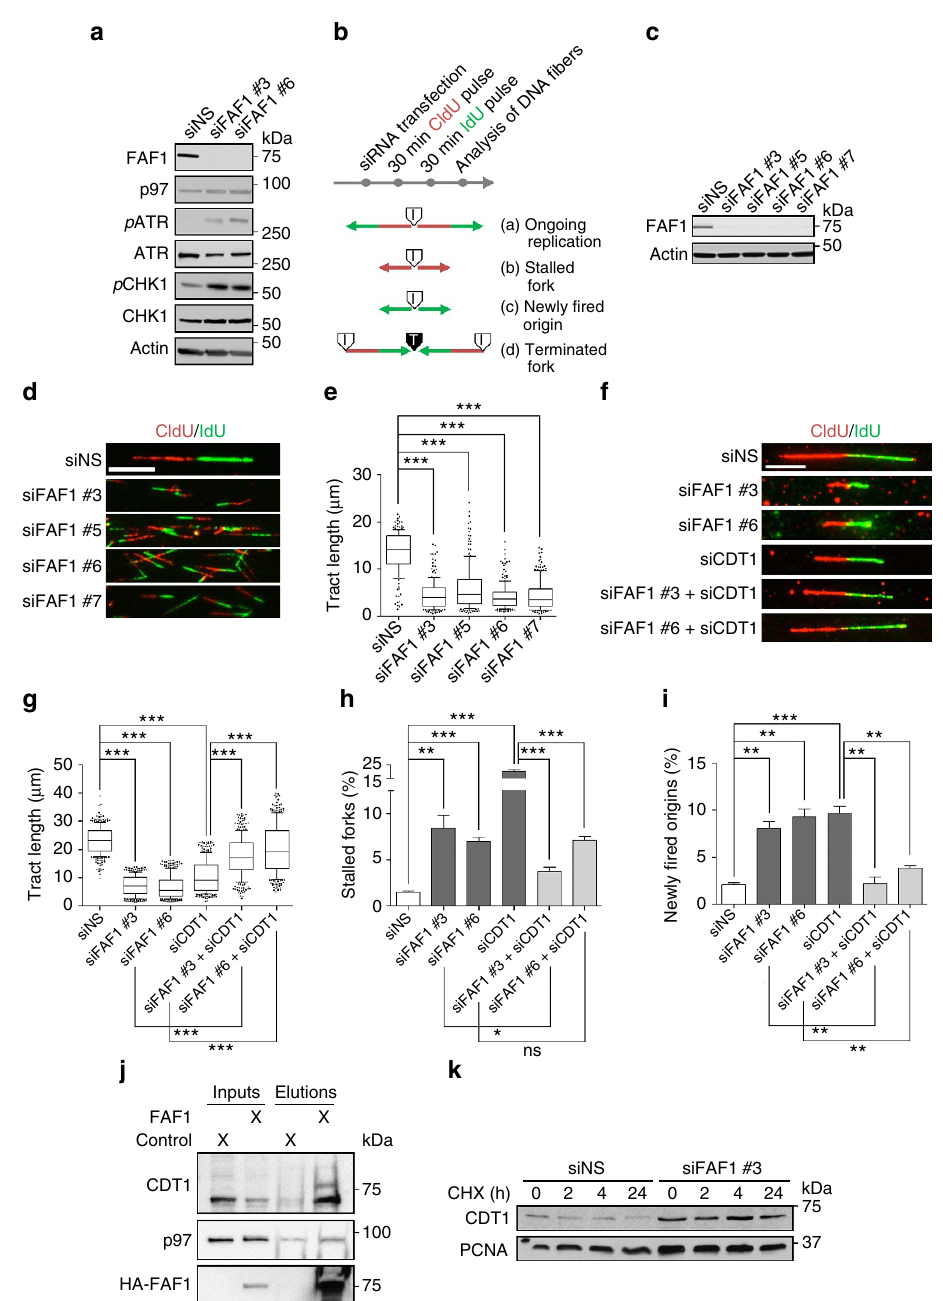
Figure 6 | Regulation of DNA replication is conserved and FAF1-dependent in human cells. ( a ) Western blot analysis of replication checkpoint activation by phosho-specific antibodies in HEK293T cells transfected with indicated siRNAs. ( b ) Schematic illustration of DNA replication fibre analysis—(a) Indicates ongoing replication (red and green arrows), (b) stalled replication forks (red arrows only), (c) newly fired origins (green arrows only) and (d) terminated/converged forks. Sites of DNA replication initiation (I) or termination (T) are labelled, respectively. ( c ) Western blot analysis of T24 cell lysates transfected with indicated siRNAs. Efficiency of siRNA-mediated depletion is shown for FAF1 protein levels. ( d , e ) Representative images of microscopic analysis of DNA replication fibres by molecular combing in T24 cells after indicated siRNA transfection. CldU (first pulse) incorporation is shown in red, incorporated IdU (second pulse) in green. Quantification of replicated DNA tract length after indicated siRNA transfection in T24 cells. Tract length was determined for 100 individual forks per condition and experiment. The experiment was repeated twice. Whisker box plots show mean values and data within the 10–90 percentile. ( f – i ) Representative images of microscopic analysis of DNA replication fibres by molecular combing in U2OS cells after indicated siRNA transfection. Quantification of replicated DNA tract length, stalled replication forks and newly fired dormant origins after indicated siRNA transfection in U2OS cells. Tract length was determined for 100 forks per condition and experiment. Fork stalling and origin firing was quantified for 400 forks per condition and experiment. The experiment was repeated in three replicates. ( j ) Western blot analysis of control HA and HA-FAF1 co-IPs. Nuclear lysates were prepared from HEK cells expressing the p97-E587Q variant. ( k ) HEK cells were depleted for control or FAF1 by siRNA. CDT-1 and PCNA levels were monitored at indicated time points after CHX treatment by western blot analysis. Scale bar, 5 m m. Data show mean values. Error bars represent s.d.. The single asterisk indicates a P value of r 0.05, the double asterisk r 0.001 and the triple asterisk indicate P values of r